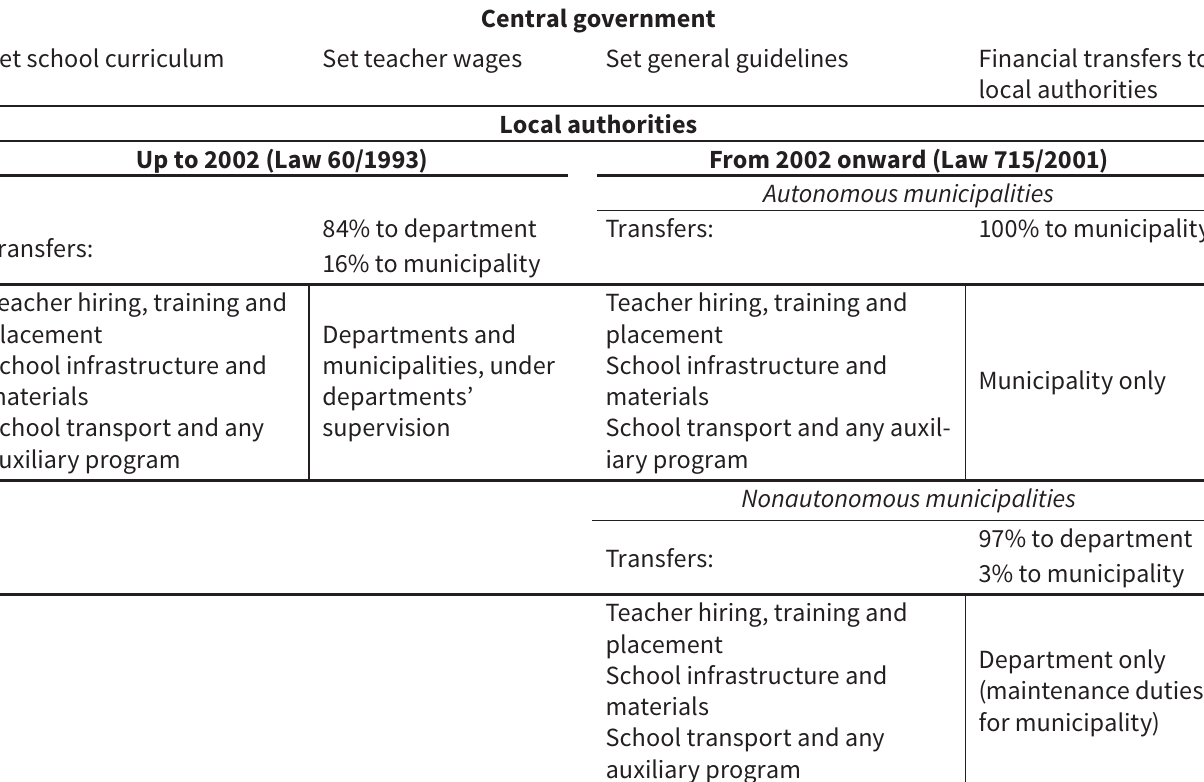
Education Responsibilities and transfers by level of government Central government Set school curriculum Set teacher wages Set general